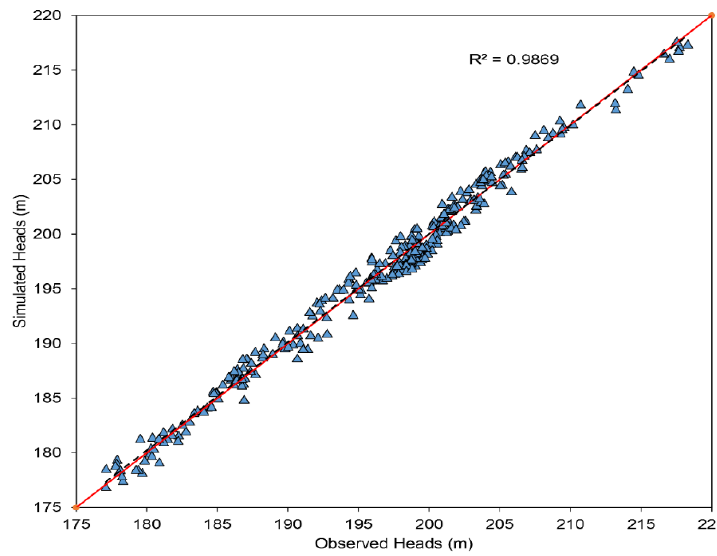
Figure 7. Scatter plot of the observed and simulated heads in Lahore.